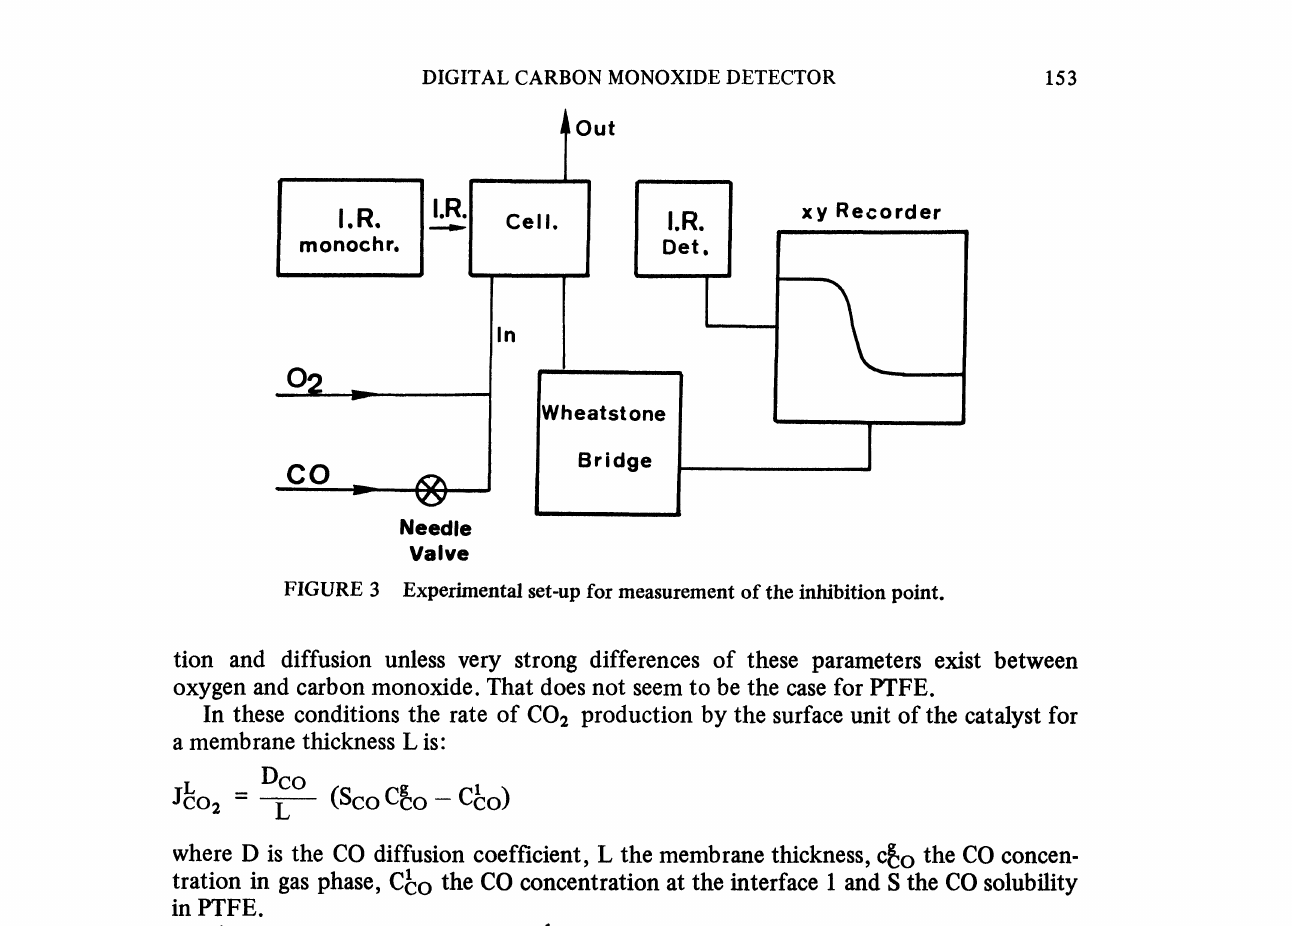
FIGURE 3 Experimental set-up for measurement of the inhibition point.